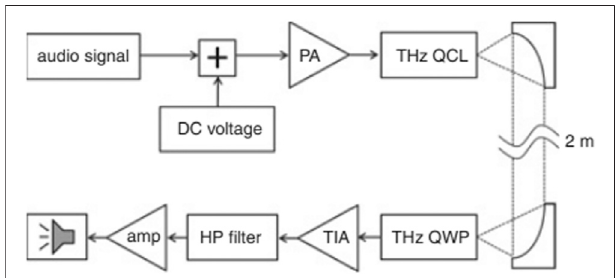
FIGURE 8 | THz audio communication system [36, 37].